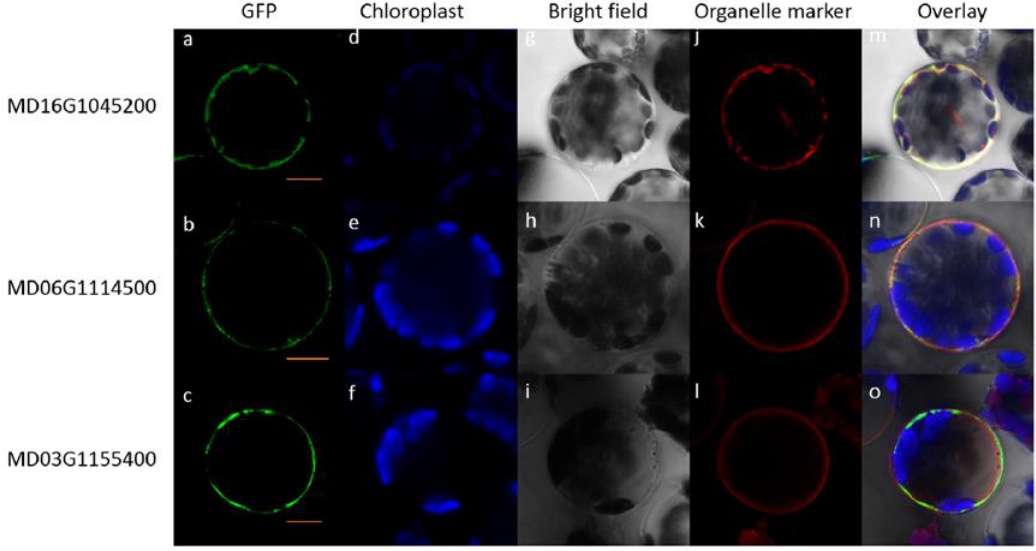
Figure 7. Subcellular localization of MD16G1045200, MD06G1114500, and MD03G1155400 proteins in Arabidopsis mesophyll protoplasts. First column ( a – c ) shows the fluorescence of the MD16G1045200-GFP, MD06G1114500-GFP, and MD03G1155400-GFP fusion protein, respectively. Second column ( d – f ) shows chloroplast autofluorescence. Third column ( g – i ) shows a bright-field image of each protoplast. j : Fluorescence of vac-rk (vacuolar marker) protein. k , l : Fluorescence of pm-rk (plasma-membrane marker) protein. Fifth column ( m – o ) represents an overlay of the fluorescent images. Bars = 5 µ